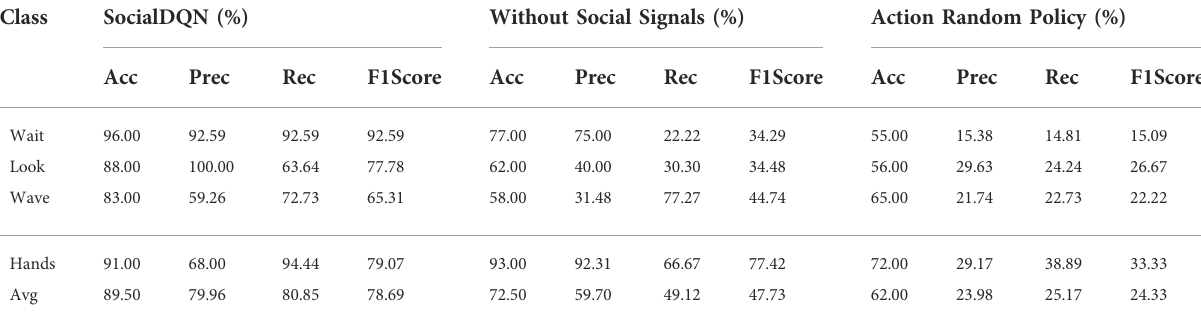
TABLE 2 Scores from confusion matrix resulted from greedy and random polices. In this table: Acc, Prec, Rec, F1Score, Hands and Avg represent abbreviations of the measures: Accuracy, Precision, Recall, F1-Score, Handshake and Average, respectively. Class SocialDQN (%)